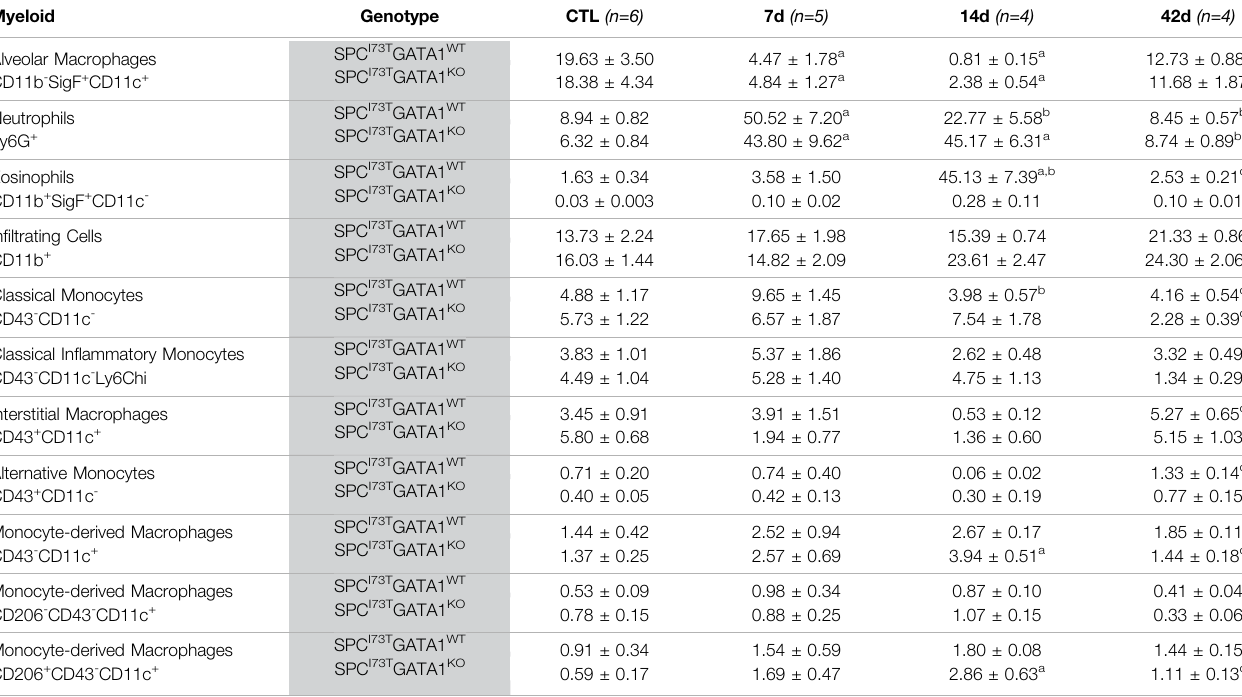
TABLE 2 | Myeloid populations (relative abundance) in the lung of SP-C I73T GATA1 WT and SP-C I73T GATA1 KO mice.